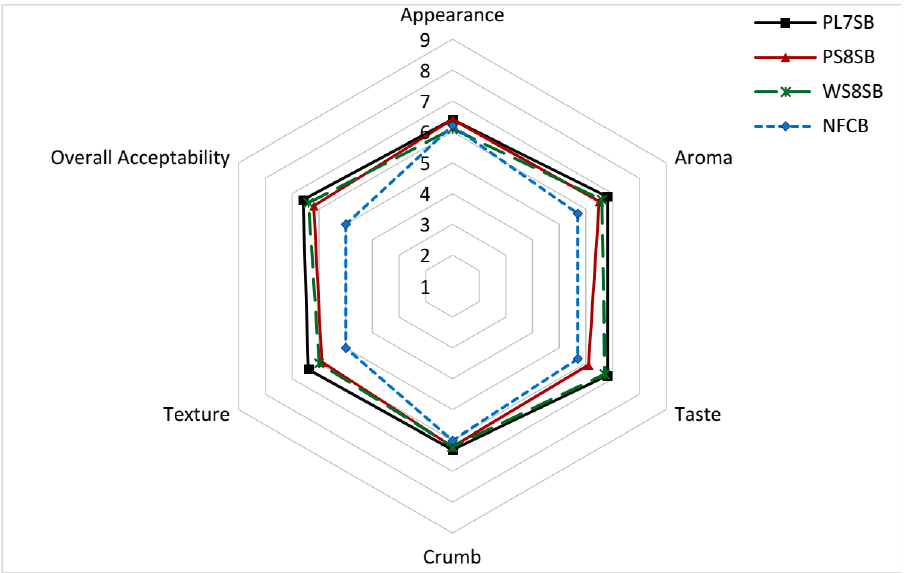
Figure 5. Sensory qualities of sourdough breads (SB) obtained with different LAB strains and control bread. PL7SB (SB with Pediococcus pentosaceus LD7); PS8SB (SB with Pediococcus pentosaceus SA8); WS8SB (SB with Weissella confusa SD8), NFCB (control bread without sourdough).